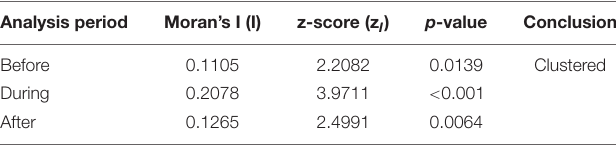
TABLE 5 | Global analysis results by analysis period for 2019, including Moran’s I value (I), the z-score (z I ), and the associated p -value. Analysis period